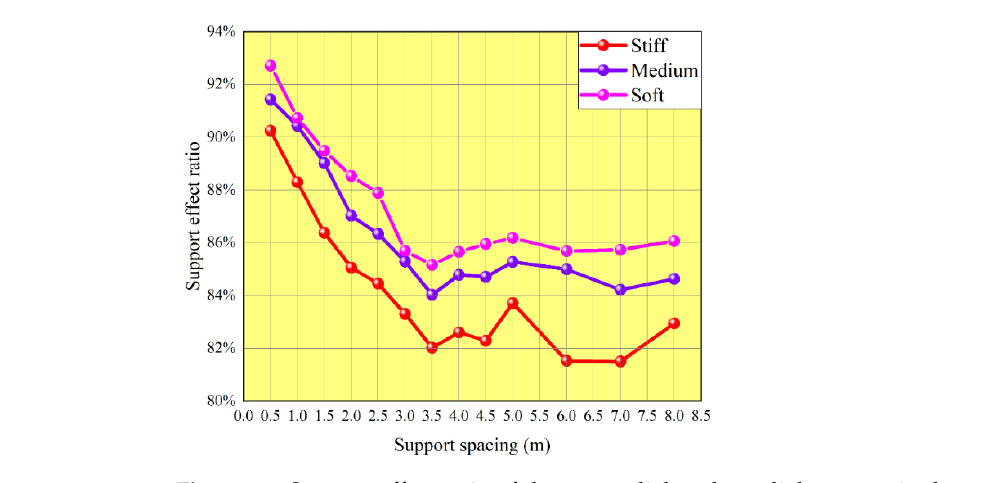
Figure 21. Support effect ratio of the non-radial to the radial support in three different geological conditions.